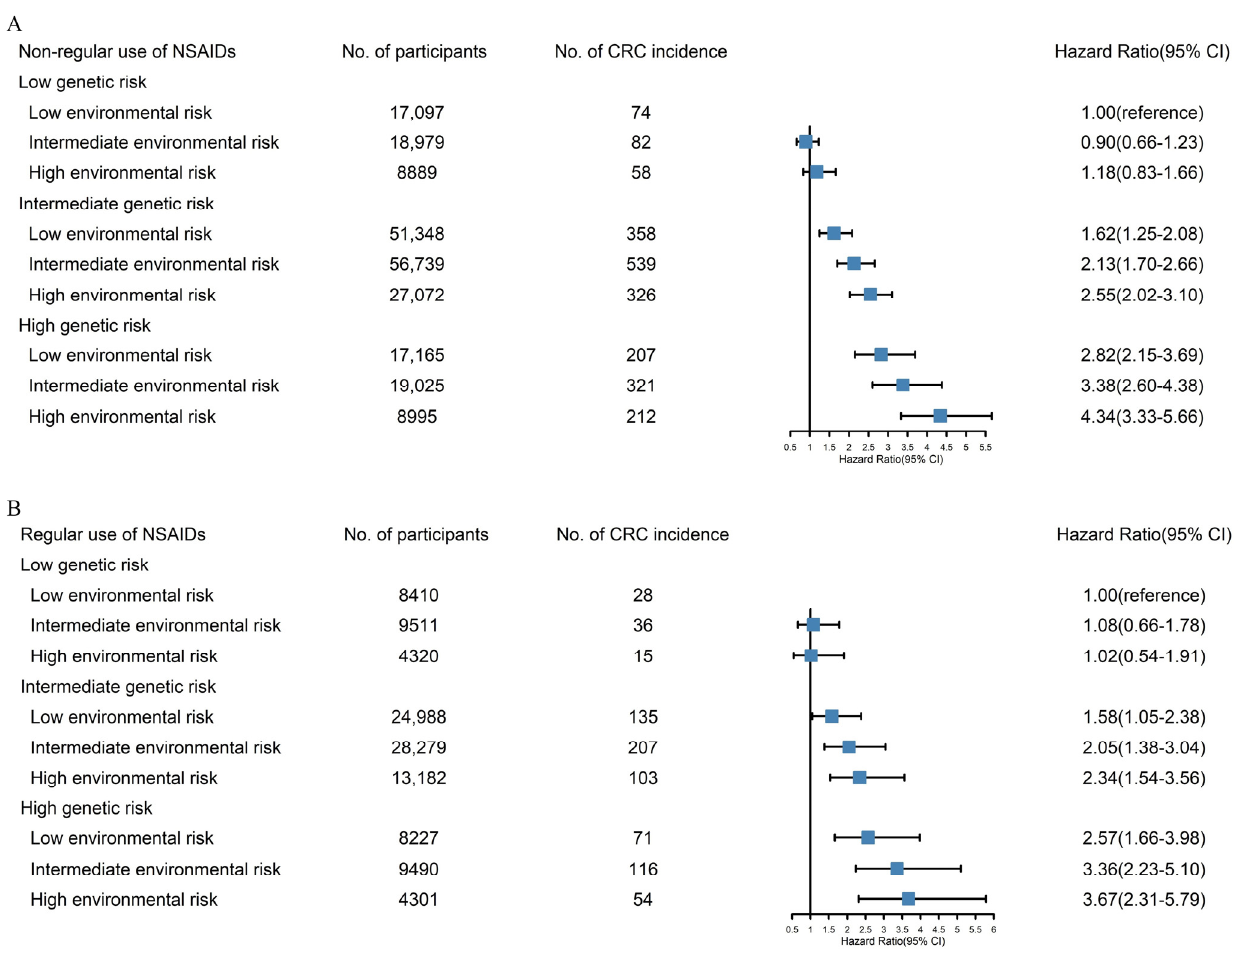
Figure 1. The CRC incidence risk in accordance with genetic risk and environmental risk according to NSAID use: ( A ) non-regular use of NSAIDs; ( B ) regular use of